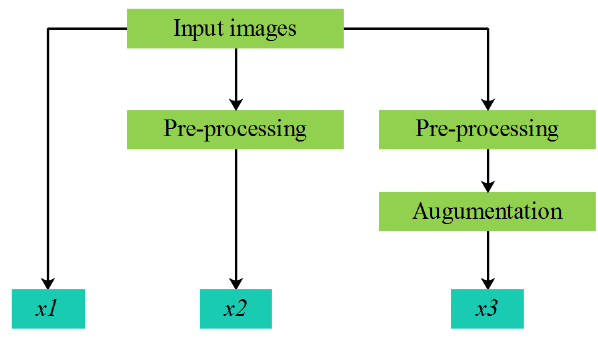
Figure 4. Hierarchical framework.